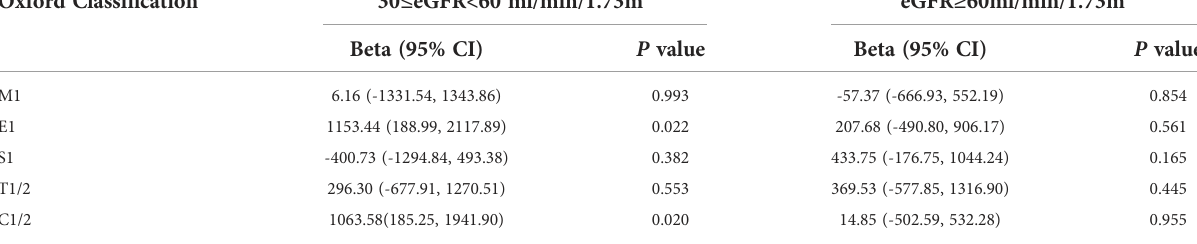
TABLE 2 Association of the Oxford Classi fi cation score MEST-C with baseline PCR at the time of renal biopsy according to 30 ≤ eGFR<60 and eGFR ≥ 60 ml/min/1.73m 2 . Oxford Classi fi